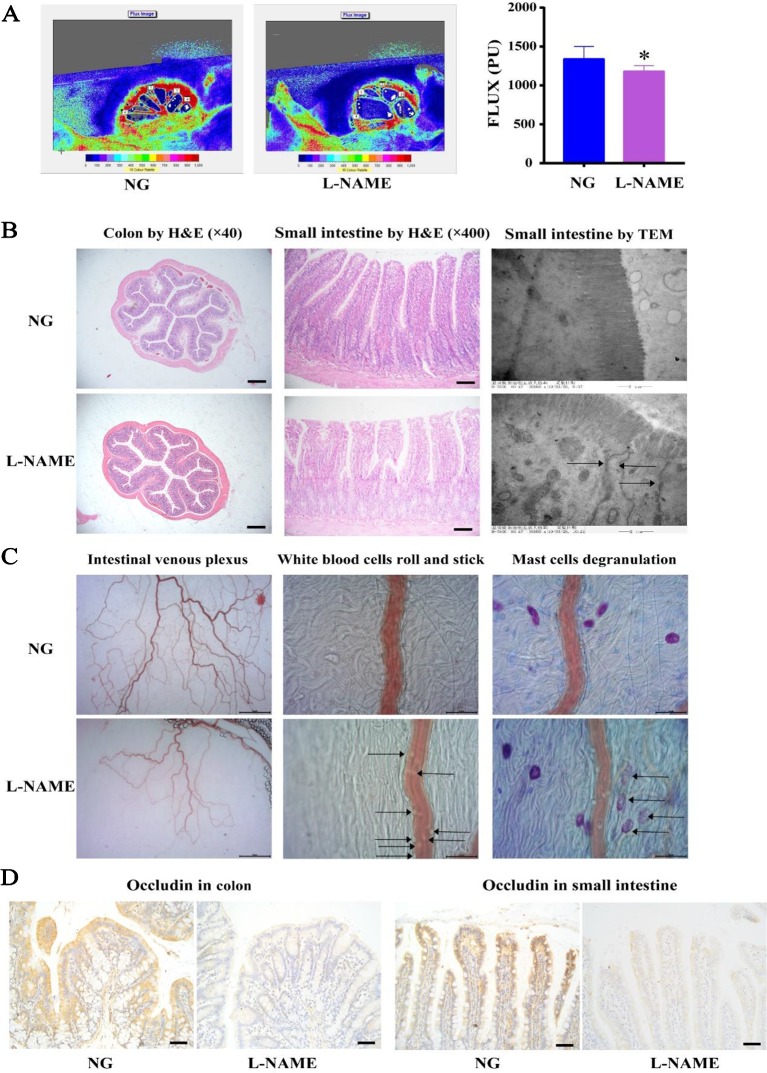
Pathophysiological alterations in the gut of the L-NAME-treated rats. (A) Changes of gross microcirculation and perfusion in the small intestine. (B) Representative photomicrograph of histological alterations in the colon (×40) and the small intestine (×200) by H&E staining, and the small intestine by transmission electron microscopy (×1,200) (the arrows indicate the disrupted tight junction proteins in the villi). (C) Representative photomicrograph of intestinal venous plexus, white blood cells roll and stick (the arrows), and mast cells degranulation (the arrows) in the small intestine. (D) Representative photomicrograph of occludin protein expression by immunohistochemistry (IHC) in the colon and the small intestine (×400). Bar = 50 μm. The data were expressed as means ± SEM. Significant differences are indicated by *P < 0.05 as compared with the NG (n = 9 per group).